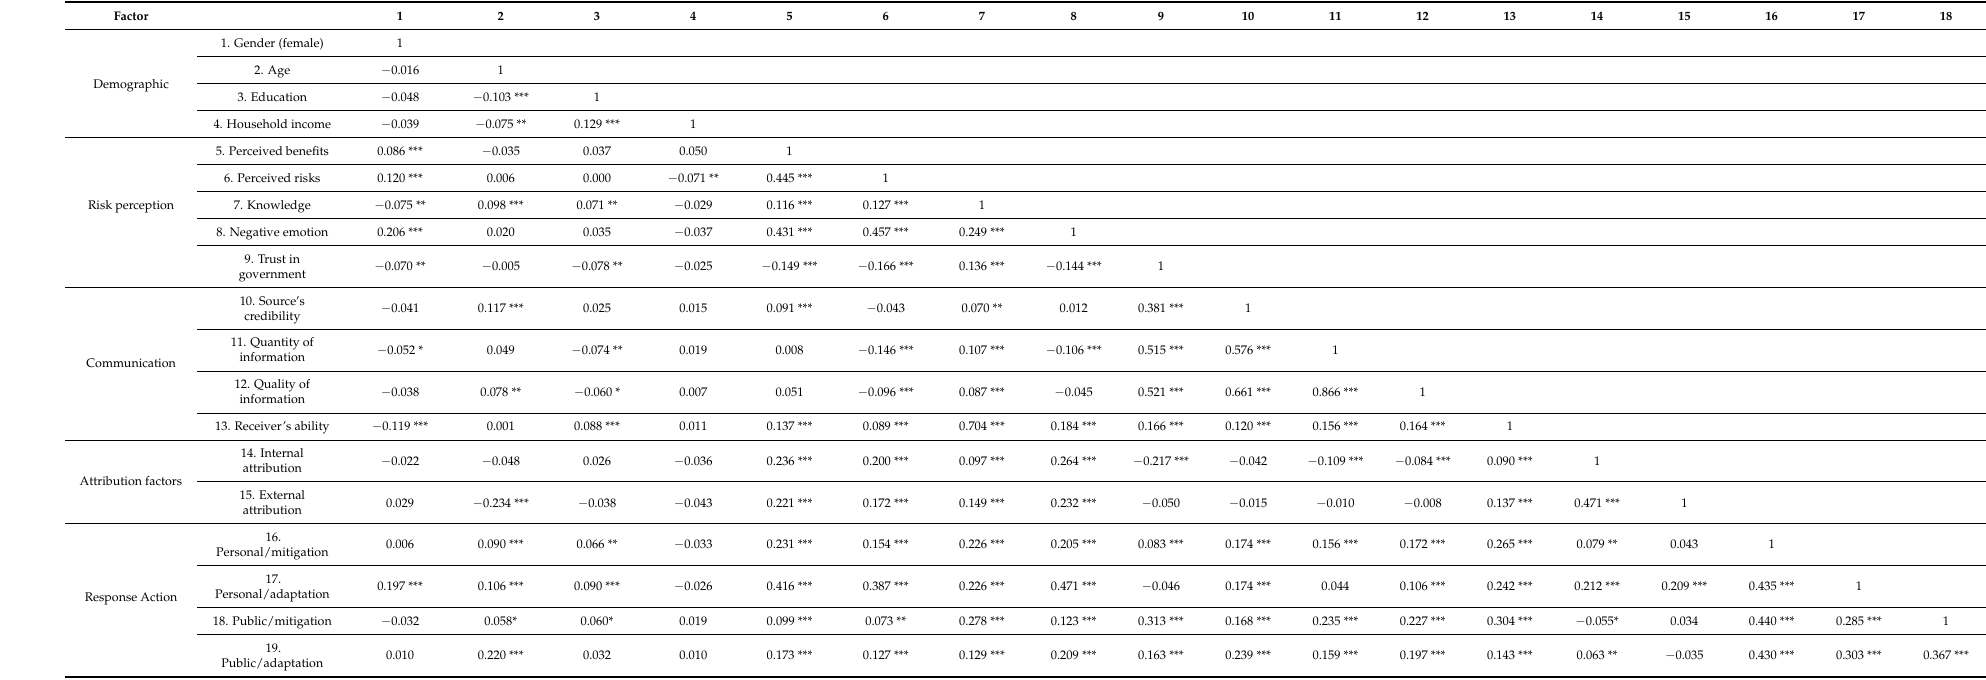
Table 5. Simple Pearson